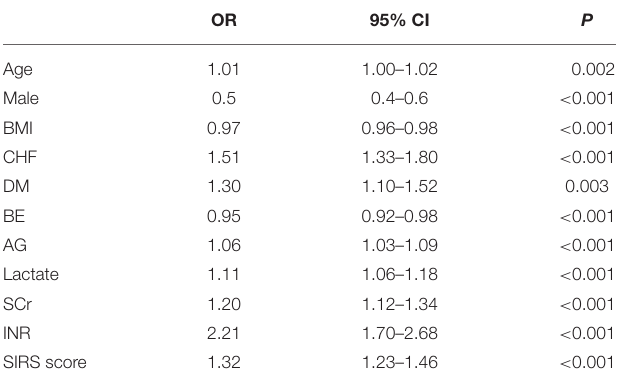
TABLE 4 | Multivariate logistic regression analysis of the associated clinical